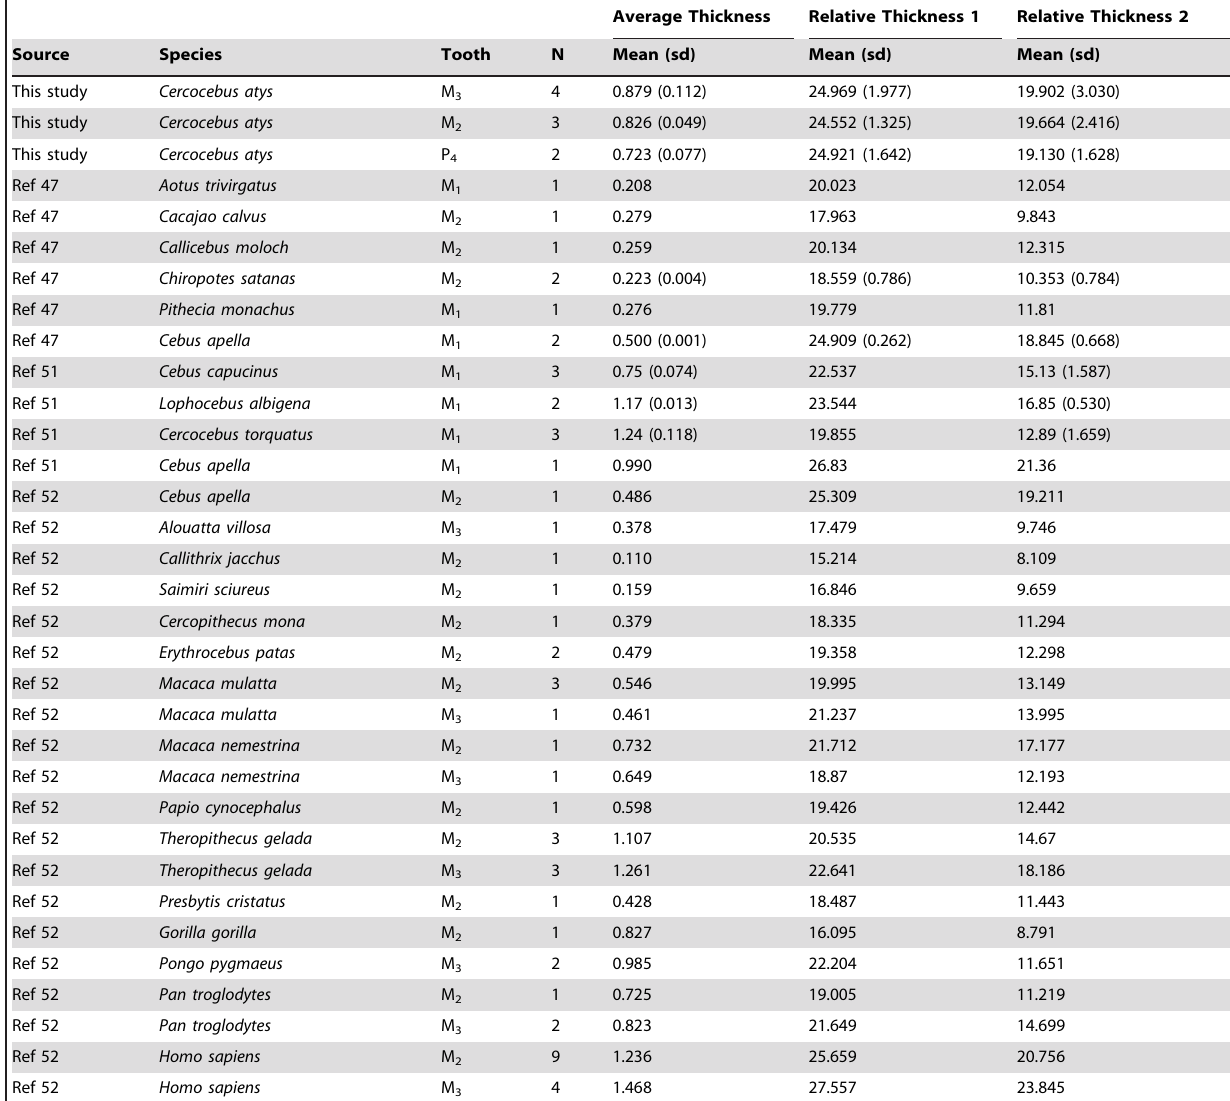
Table 4. Postcanine Enamel